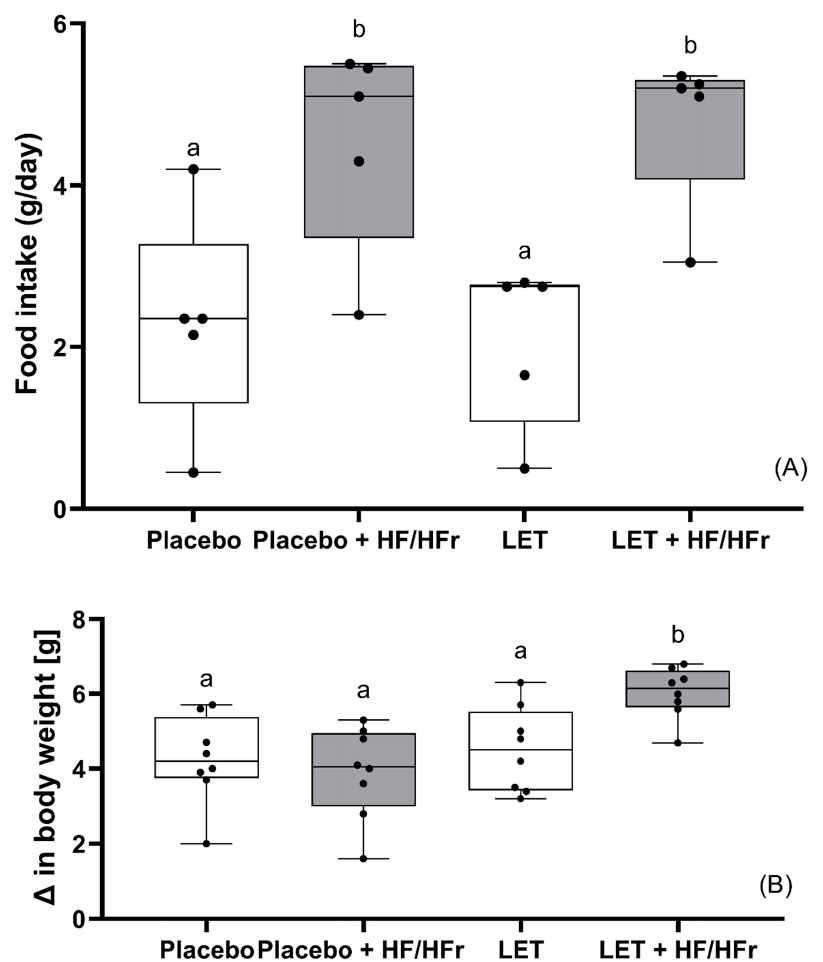
Figure 1. Effects of HF/HFr (high fat/high fructose) diet on food intake ( A ) and changes in body weight ( B ) in placebo or LET-treated (letrozole-treated) mice. The data are presented as medians, with boxes and whiskers representing the interquartile range and the 5th–95th percentiles ( n = 8 per group), analyzed using one-way ANOVA followed by Tukey’s post hoc test. Values with different letters show statistically significant differences ( p < 0.05).